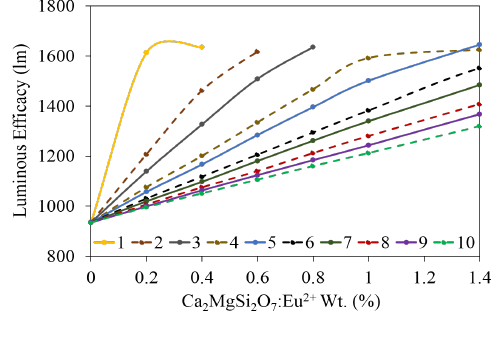
Fig. 3: The luminous e(cid:30)cacy of WLEDs as a function of the size and concentration of Ca 2 MgSi 2 O 7 :Eu 2+